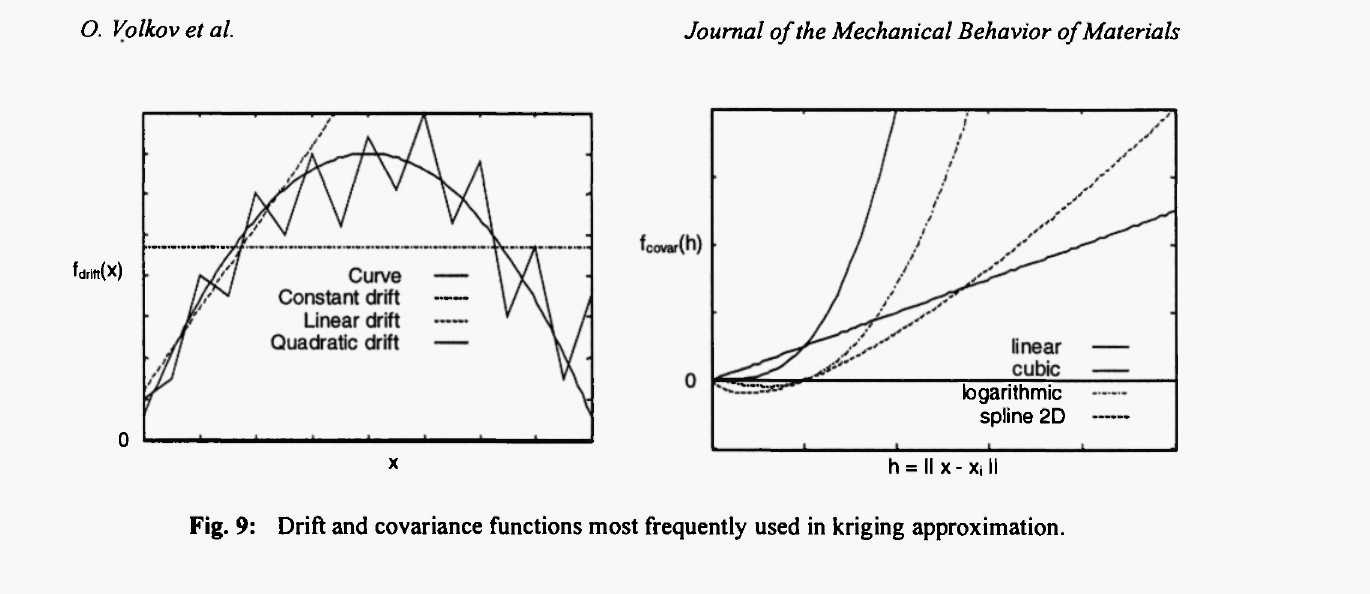
Fig. 9: Drift and covariance functions most frequently used in kriging